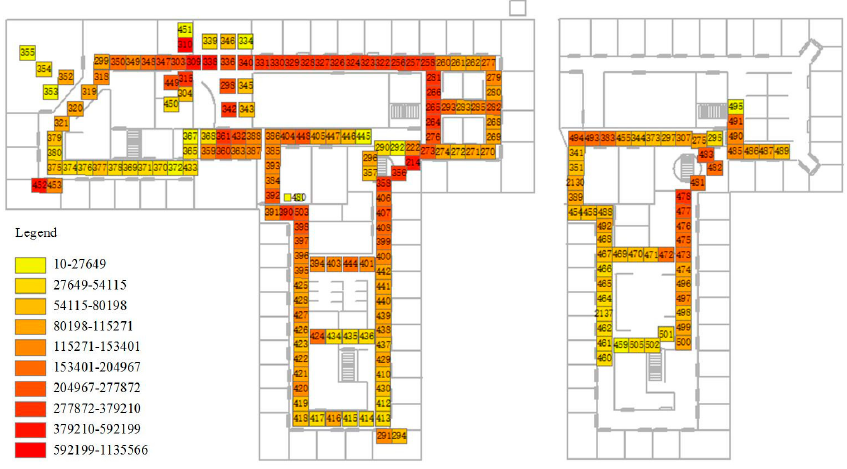
Figure 7. Spatial distribution of the sensor activation.